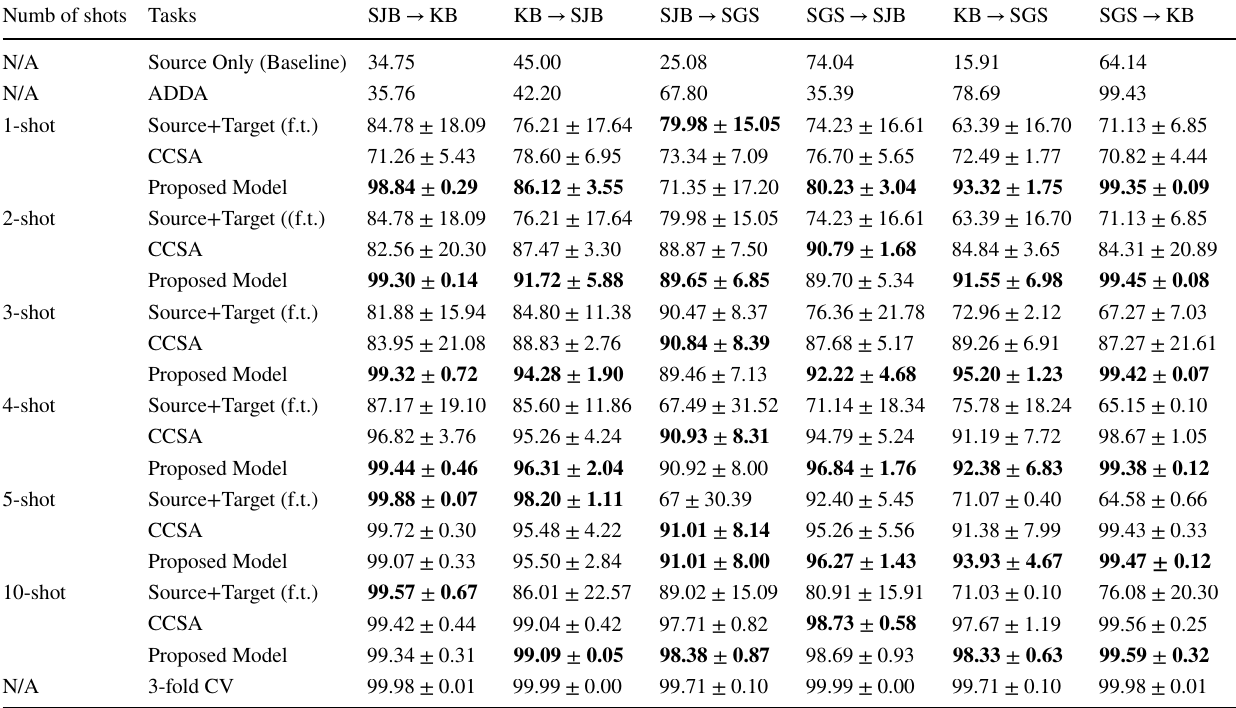
Table 2 Classification results in target domain by different methods (All numbers are in %) → Numb of shots Tasks SJB KB N/A Source Only (Baseline) 34.75 Source+Target (f.t.) Proposed Model Source+Target